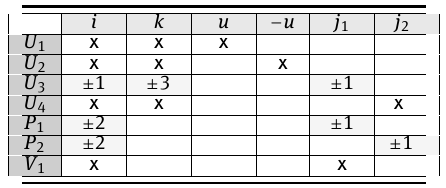
Table 10. Index distribution on C i ∪ D i ∪ E i and on 2 words of type [± 2, ± 1 ] .